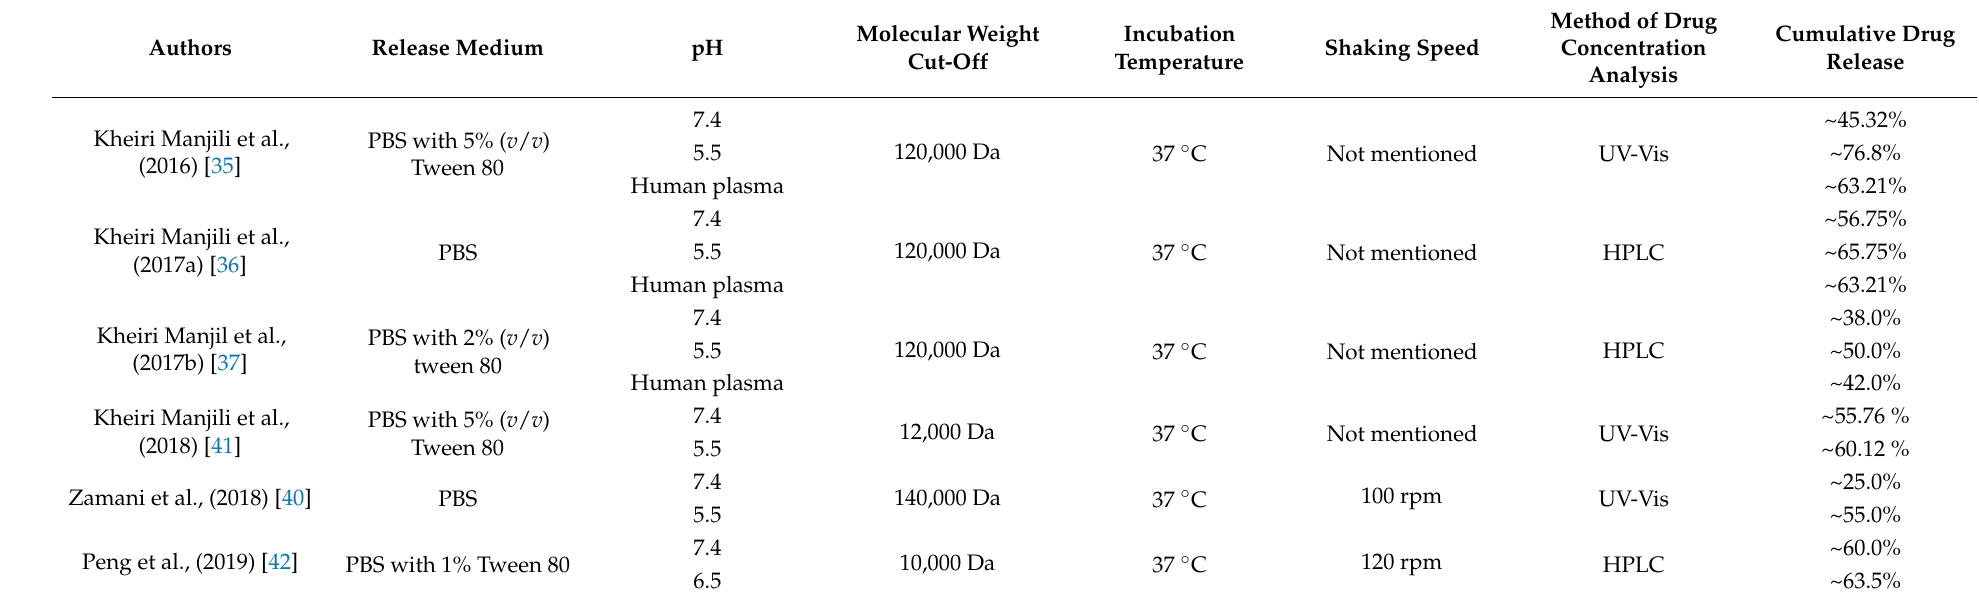
Table 7. Drug release study of drug-loaded PCL-PEG